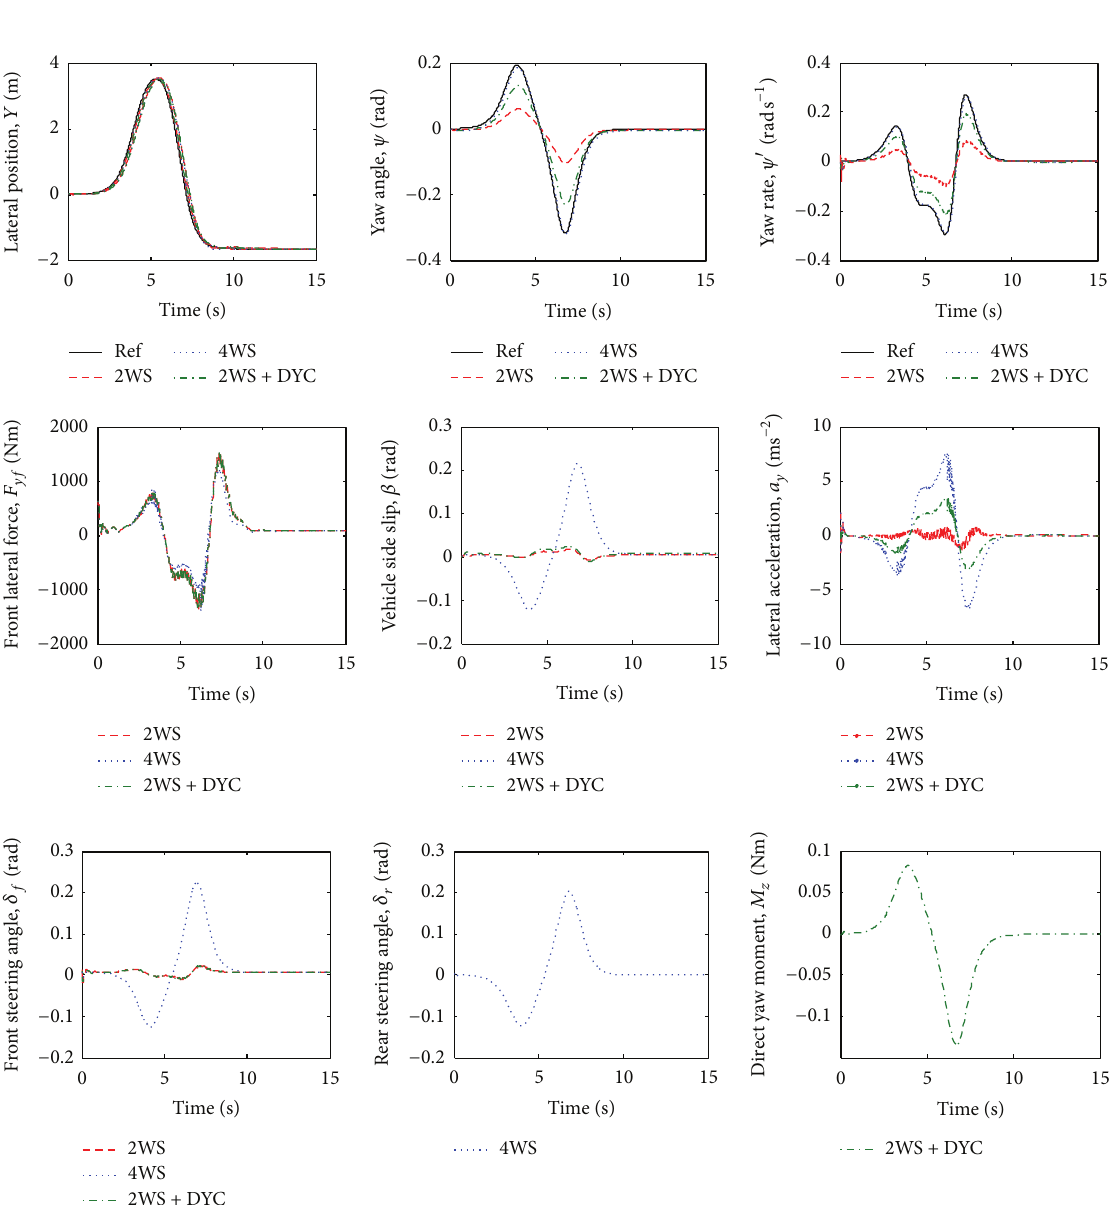
Figure 13: 3DoF controller at 30 ms −1 and 𝜇 = 0.7 by 2WS, 4WS, and 2WS + DYC.